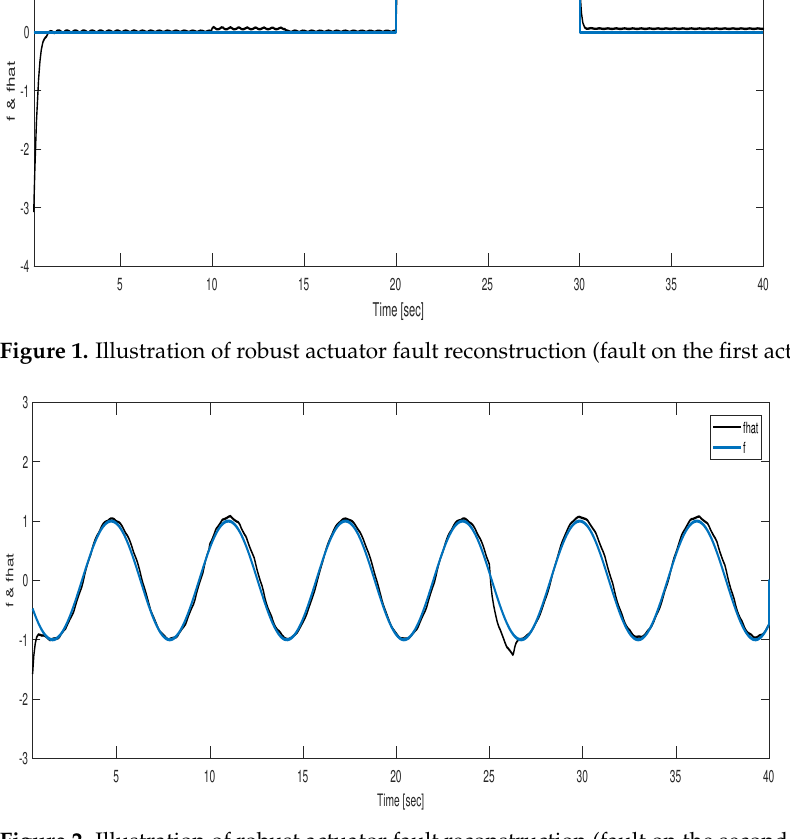
Figure 2. Illustration of robust actuator fault reconstruction (fault on the second